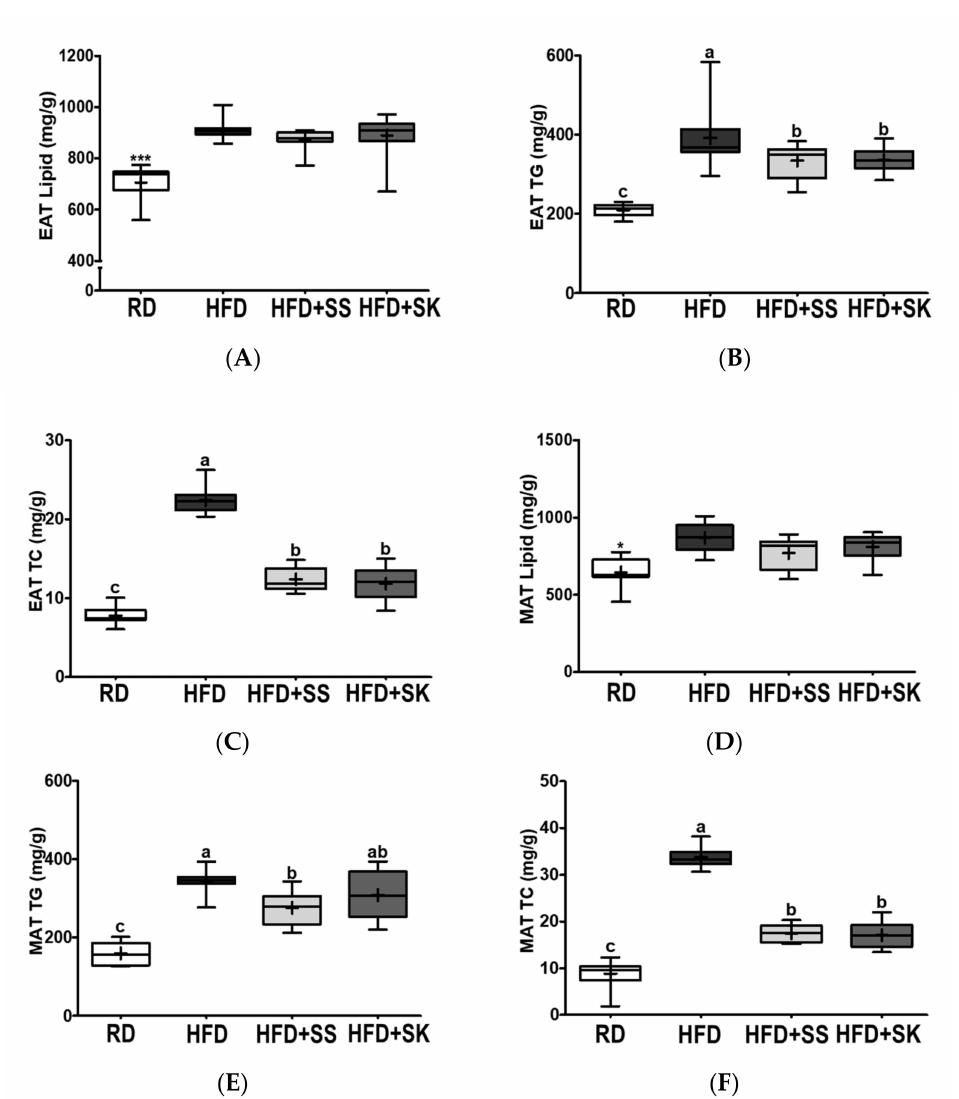
Figure 6. Effect of steamed soybean (SS) and soybean koji (SK) on lipid, triglyceride (TG), and total cholesterol